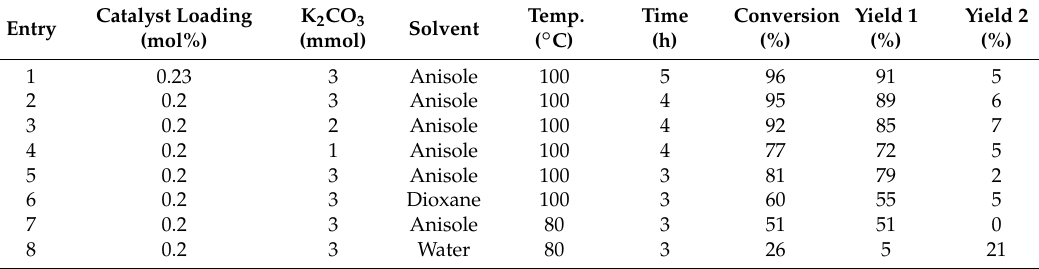
Table 2. Optimization of the carbonylative Suzuki–Miyaura reaction using Pd/GO-TiO 2 a .